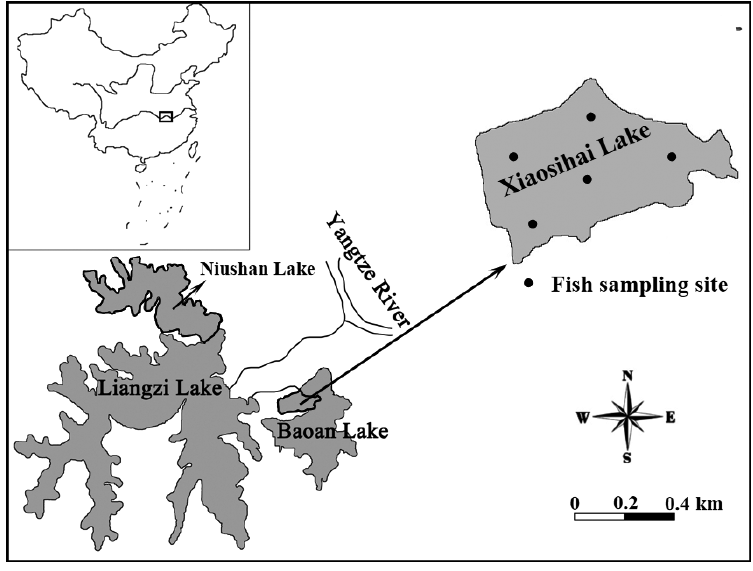
Fig. 1. Location of Xiaosihai Lake, showing the gill-net sampling